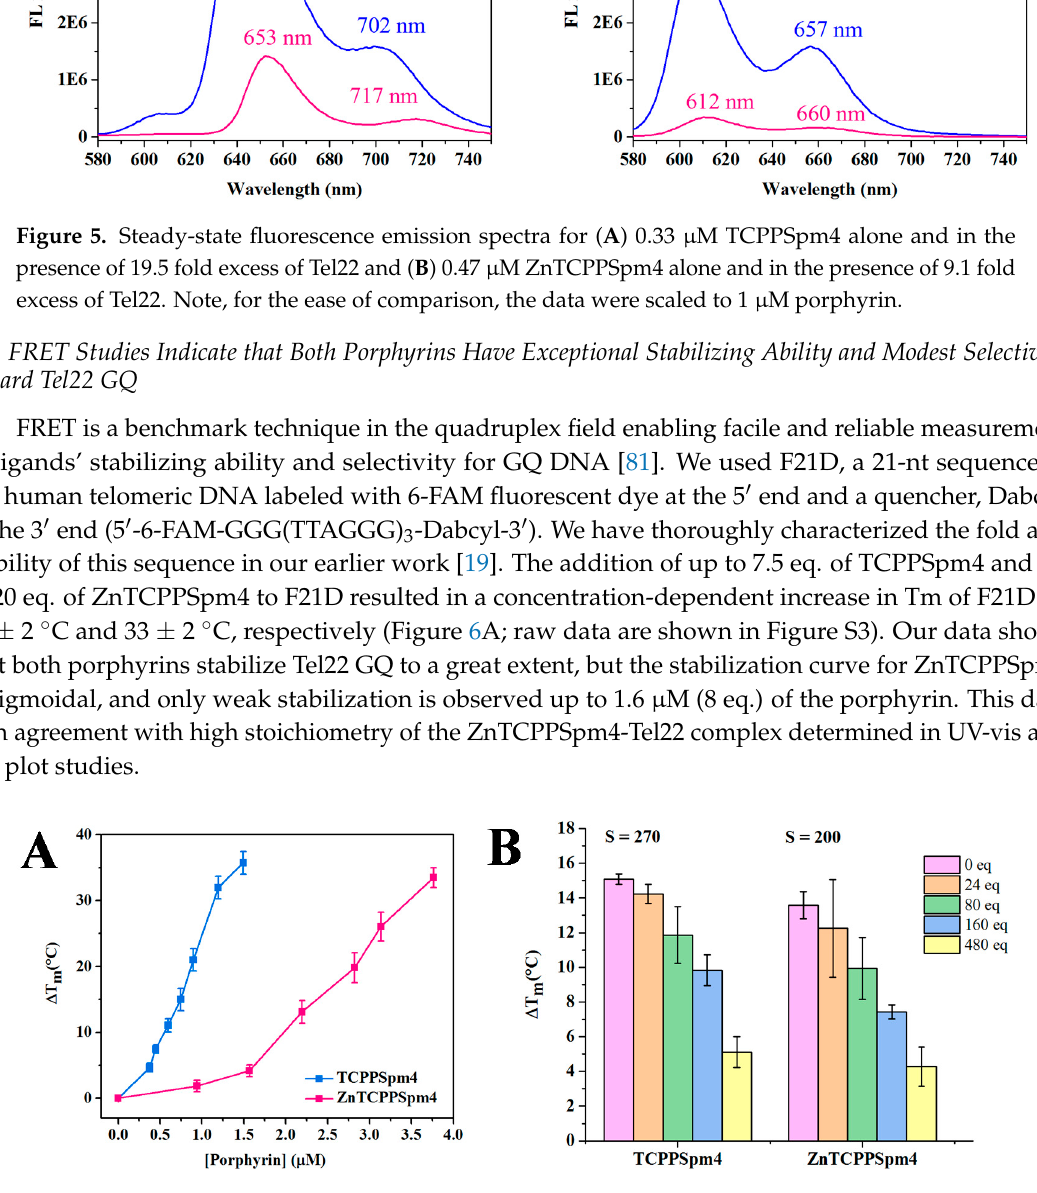
Figure 6. Stabilizing ability and selectivity of TCPPSpm4 and ZnTCPPSpm4 toward human telomeric DNA investigated via FRET. ( A ) Dose dependent stabilization, Δ Tm, of 0.2 µM F21D as a function of porphyrin concentration. ( B ) Stabilization of 0.2 µM F21D with 0.75 µM TCPPSpm4 or 2.2 µM